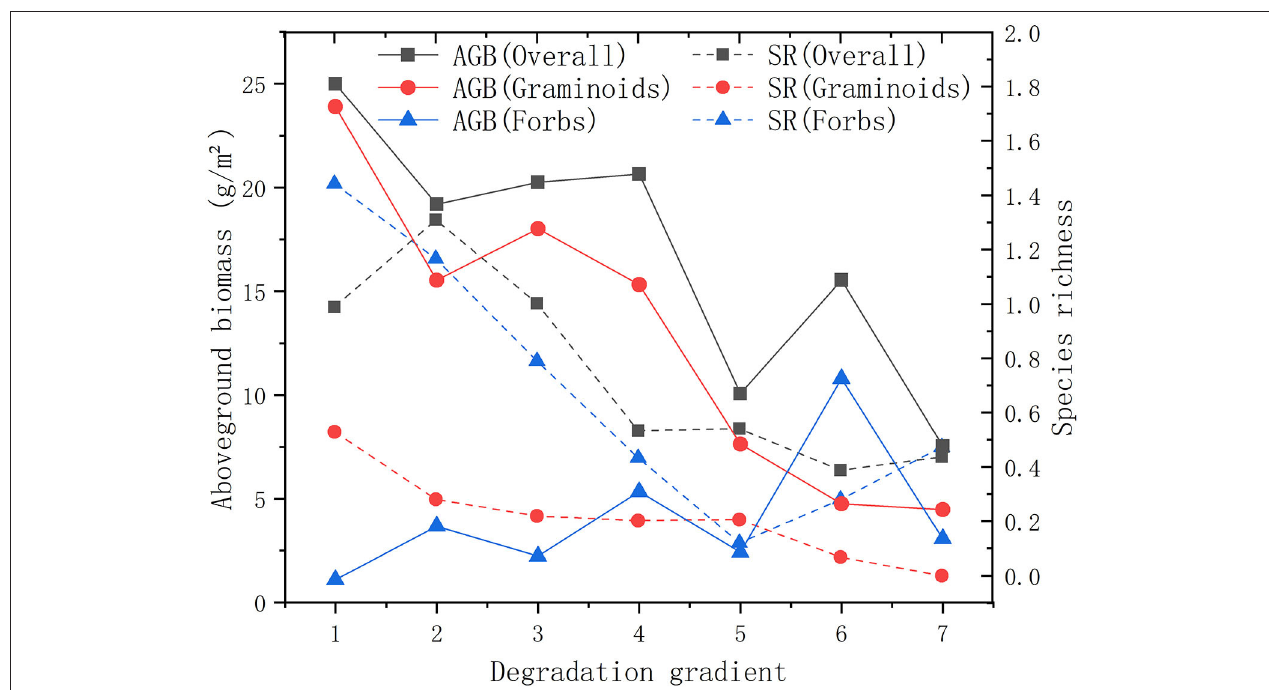
FIGURE 4 | Changes in the trade-off values of aboveground biomass of forbs along a degradation gradient. The red dashed line represents zero value level.